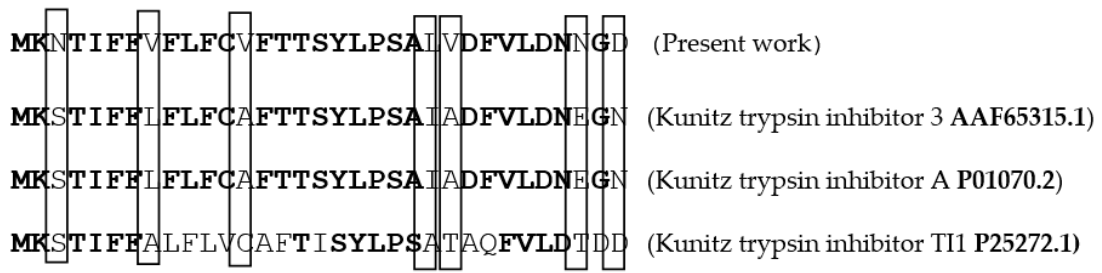
Figure 2. N-terminal sequence analysis of PDInhibitor from C. dioscoridis: Identical amino acids are in bold, and different amino acids are in boxes.